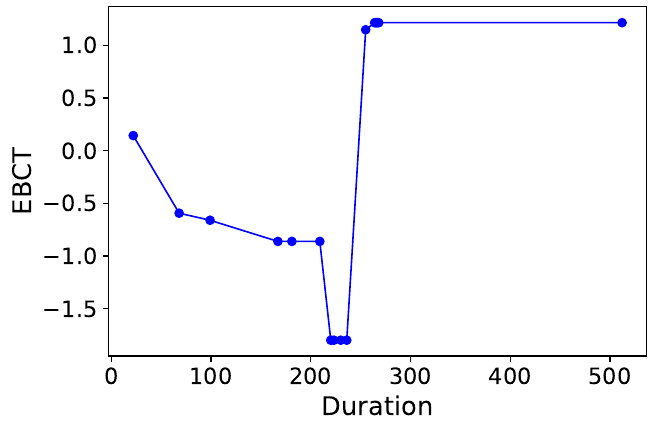
Figure A15. Normalized empty-bed contact time for Reactor 2.